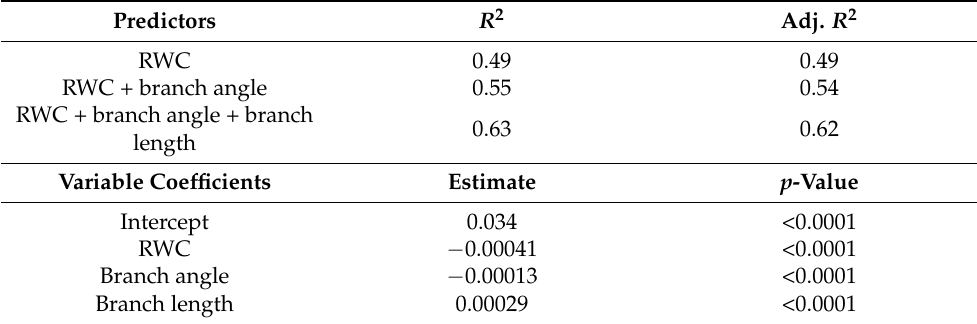
Table 3. Coefficient of determination ( R 2 ) and adjusted R 2 (Adj. R 2 ) of multiple regression models explaining variation in branch movement ( n = 171) in Scots pine seedlings. The predictors were relative water content (RWC), branch angle and branch length. Variable coefficients are given for the model including all predictors.